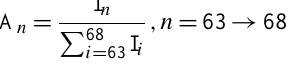
Table 1. Isotopomeric abundances for the labeled standard and ambient DMS. Indicated masses are protonated DMS (molecular weight +1). Precision is estimated to be ±